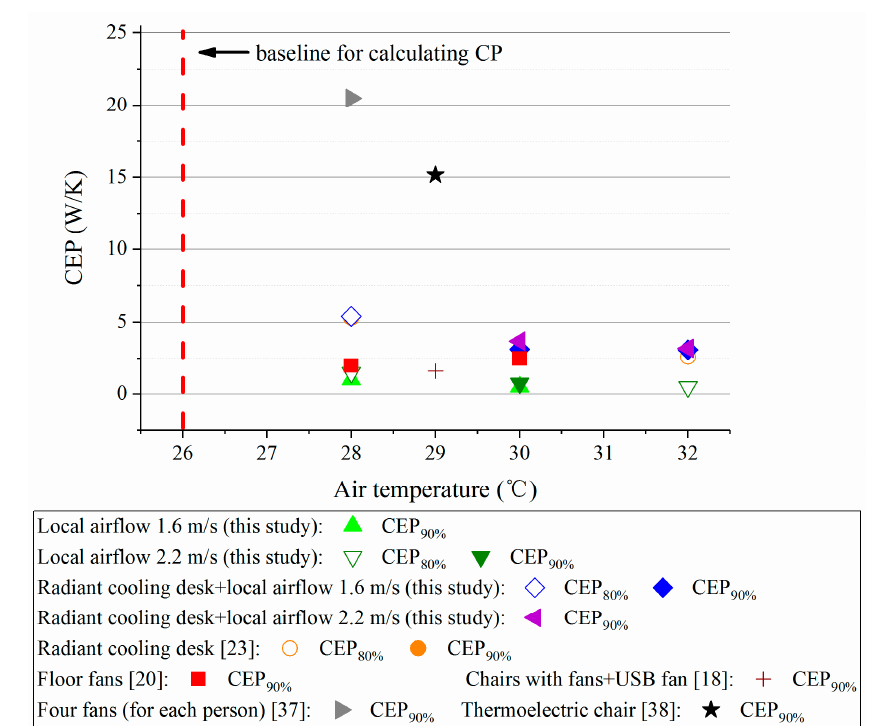
Figure 13. Comparisons with previous studies on personal cooling systems.